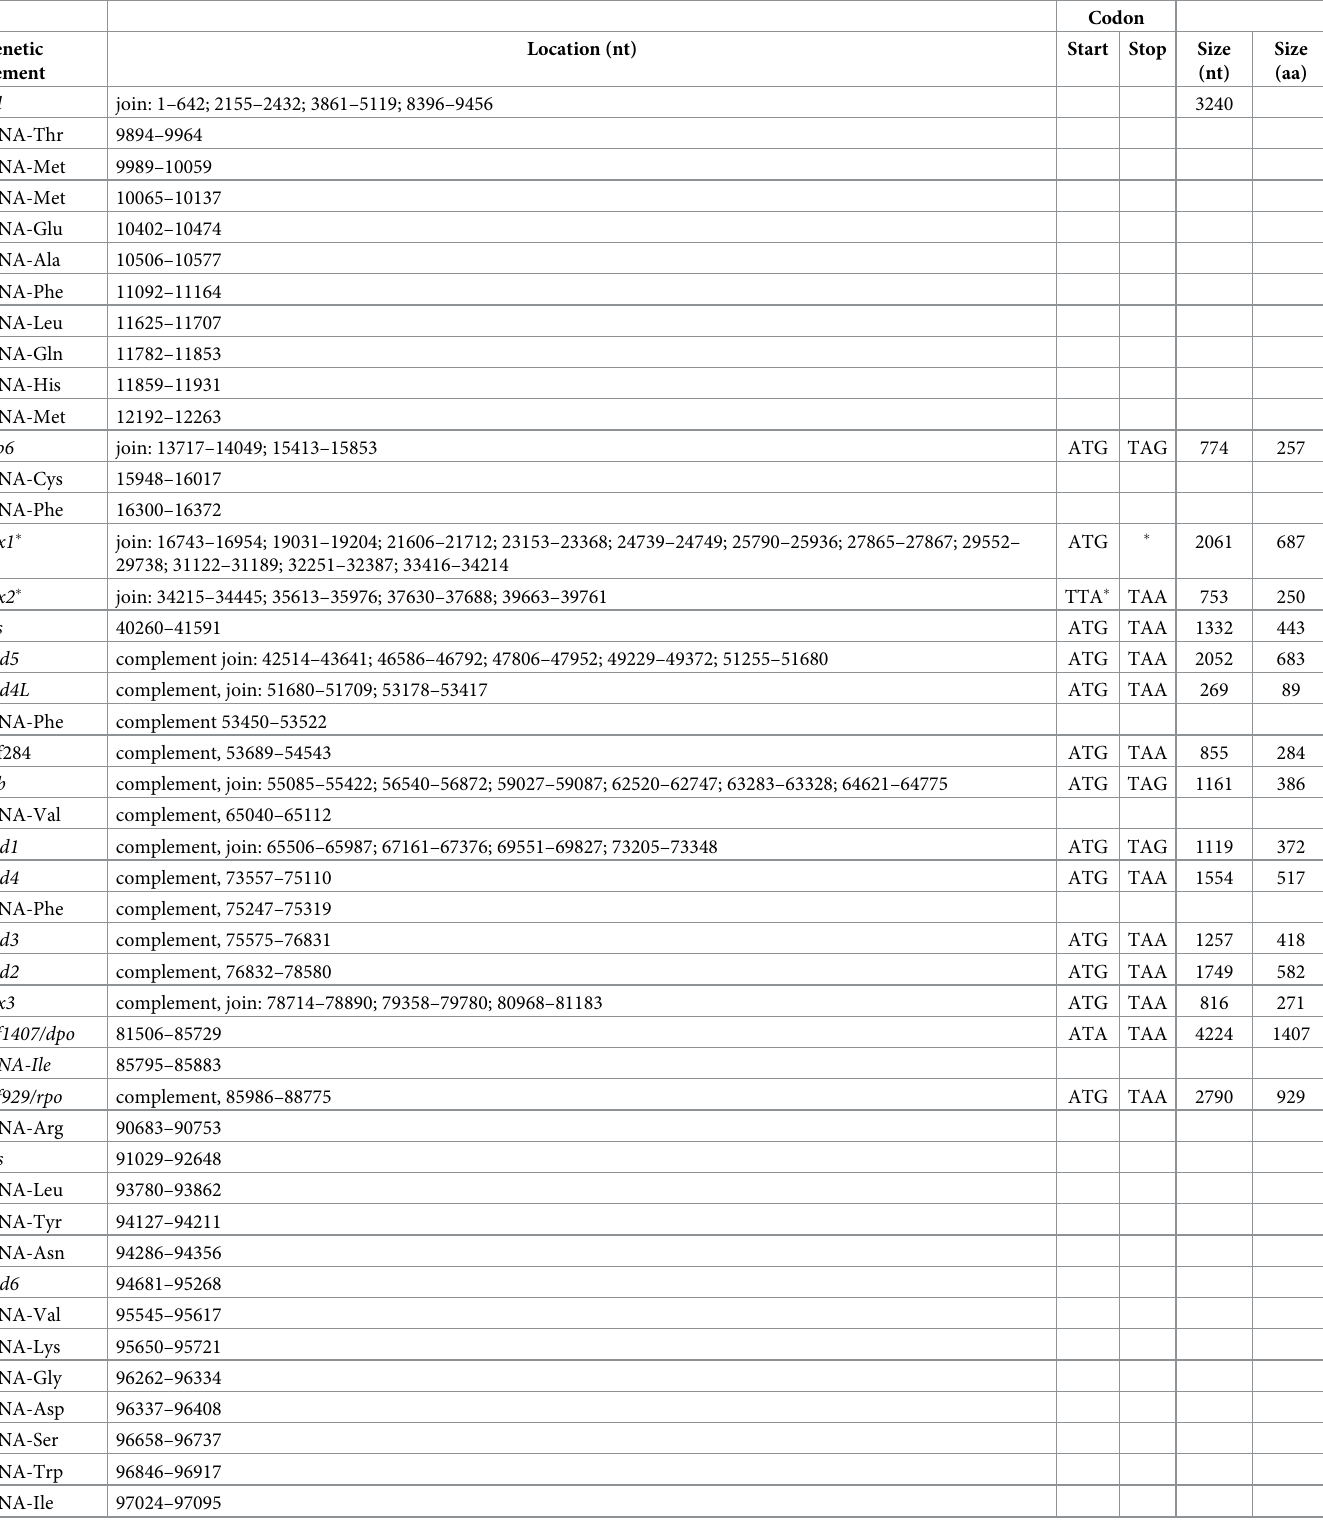
Table 1. Gene content of the Coniothyrium glycines mitochondrial genome. Genetic element